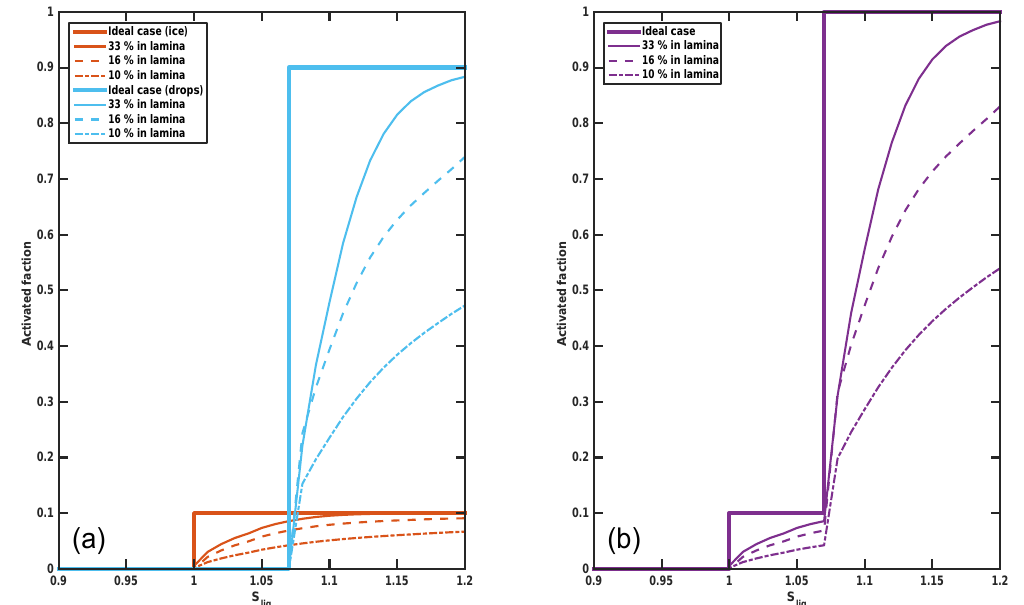
Figure 10. Fraction of particles that activate as a function of saturation with respect to liquid water. Unlike Fig. 8, where all particles are assumed to be perfect immersion INPs which activate as ice crystals when exposed to water saturation ( S liq = 1), only 10% of particles are assumed to be perfect immersion INPs. In the ideal case where all particles are constrained within the lamina ( f lam 100%; all particles exist within the dash-dotted lines in Fig. 2), 10% of particles nucleate ice at a CFDC saturation of S liq = 1 ( a , bold red line). The remaining 90% of particles are assumed to be perfect CCN that activate at S liq = 1. Droplets only survive the evaporation region of the chamber at S liq > 1 . 07 (corresponding to a “droplet breakthrough” point; bold blue line – see text and Garimella et al. (2016) for details). The other three curves correspond to the increasingly less ideal behavior presented in Fig. 8, with f lam falling from 33 to 10%. In these cases, an increasingly higher maximum CFDC saturation is required so that the particles farthest from the centerline experience S liq = 1 and 1.07. The resulting activation curves if droplets and ice crystals are indistinguishable, as is the case for an OPC (i.e., a composite of the red and blue traces in a ) is shown in (b)